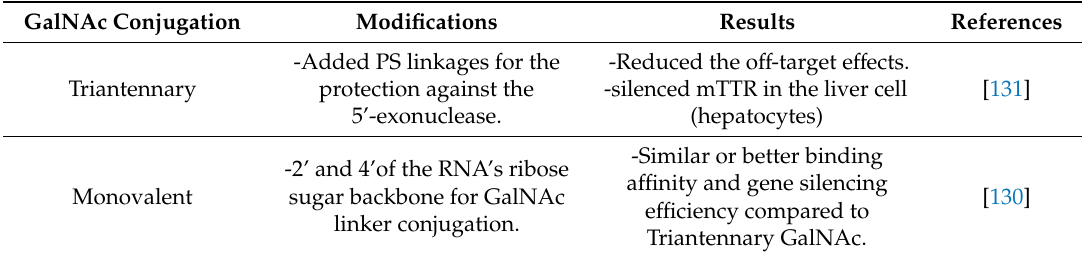
Table 5. GalNAc conjugation to overcome o ff -target e ff